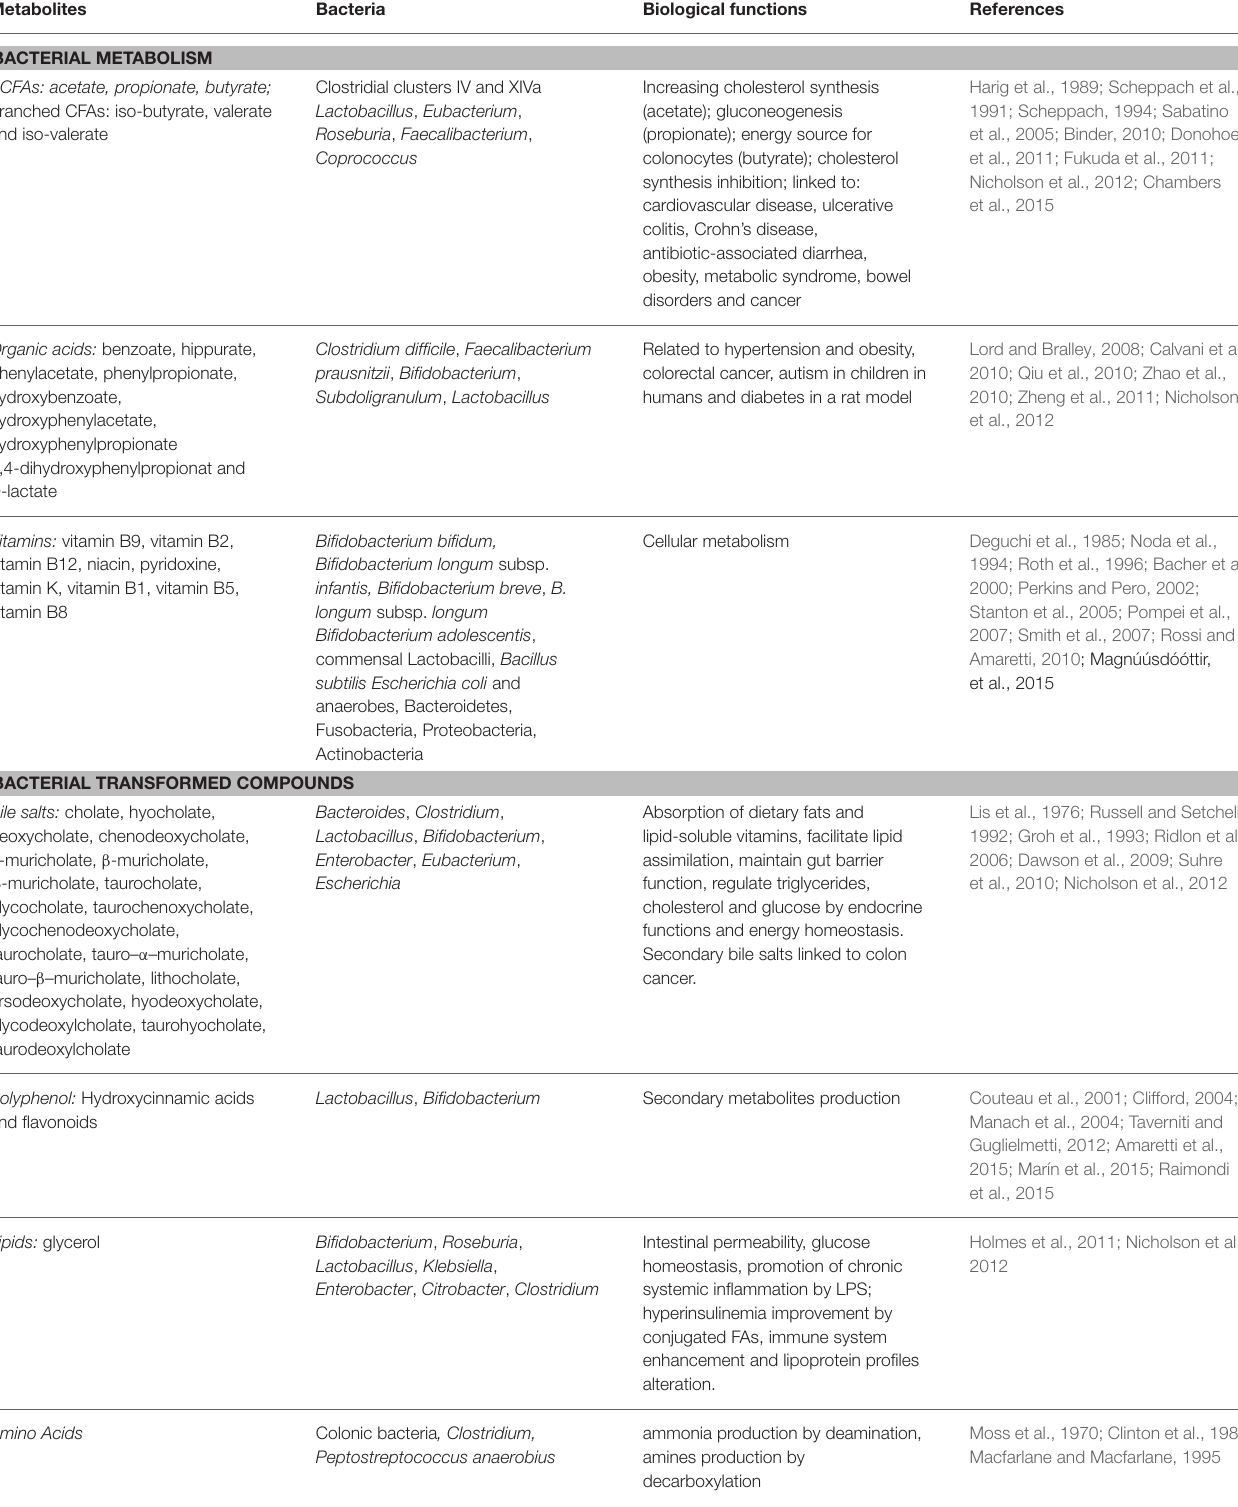
TABLE 2 | Metabolites associated with microbial metabolism or microbial–host